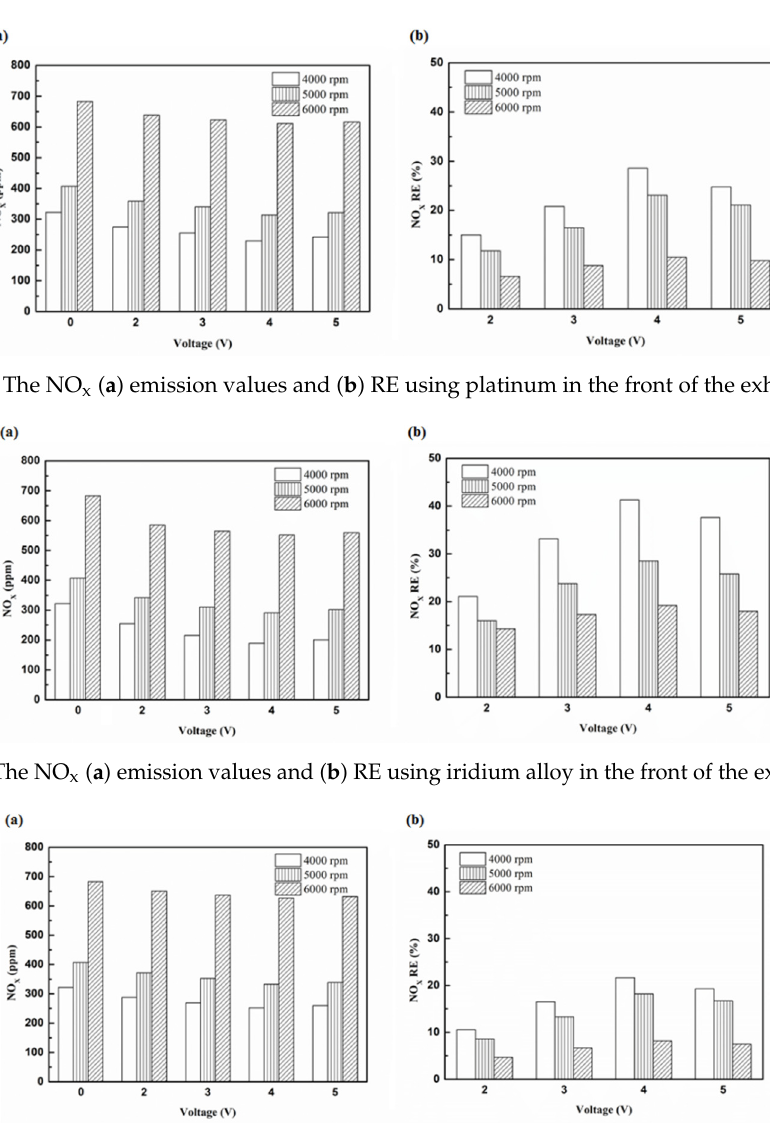
Figure 27. The oil temperature of the engine at different engine speeds.